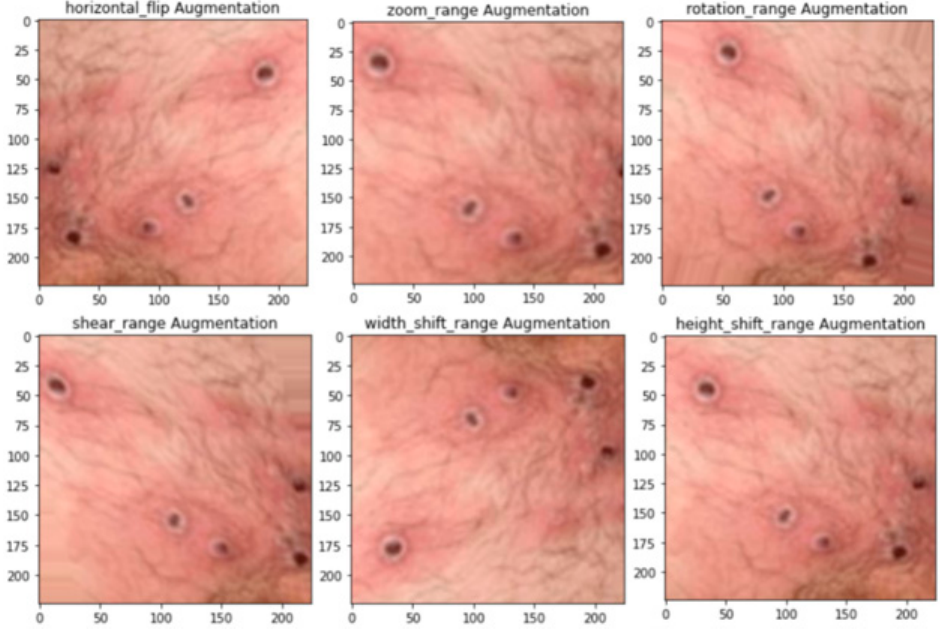
Figure 2. Data augmentation methods.